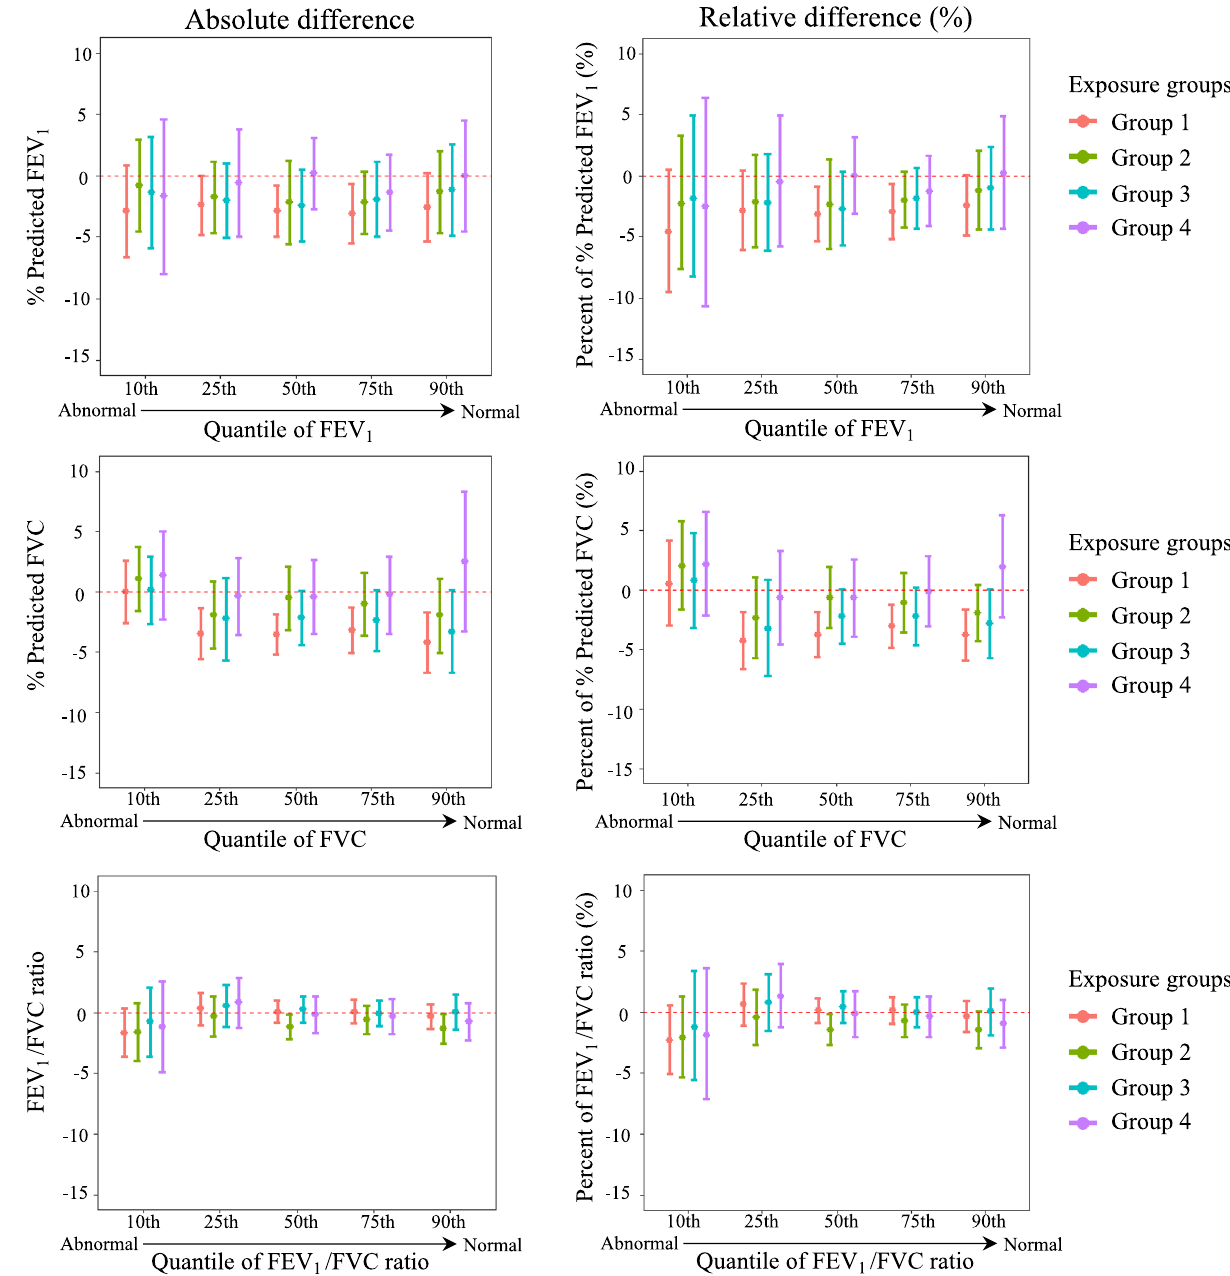
Figure 4. Estimates of absolute and relative effects on quantiles of % predicted FEV1, % predicted FVC, and FEV1/FVC ratio. X-axis denotes five quantile levels, and y-axis is the estimated absolute or relative difference on % predicted FEV1, % predicted FVC, and FEV1/FVC ratio. The colors represent four latent Group 1–4 vs. Group 5 (reference). The horizontal red dash line represents zero null effect. FEV1: pre- bronchodilator